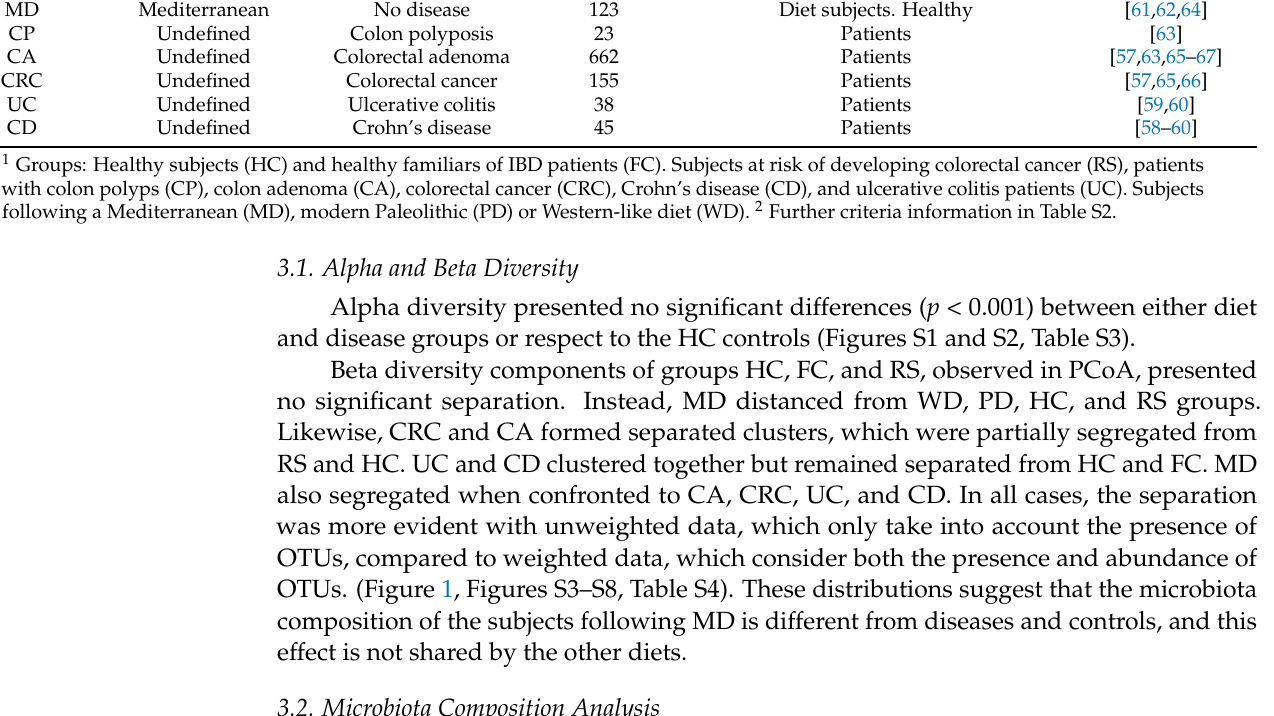
Table 1. Groups included in the meta-analysis.